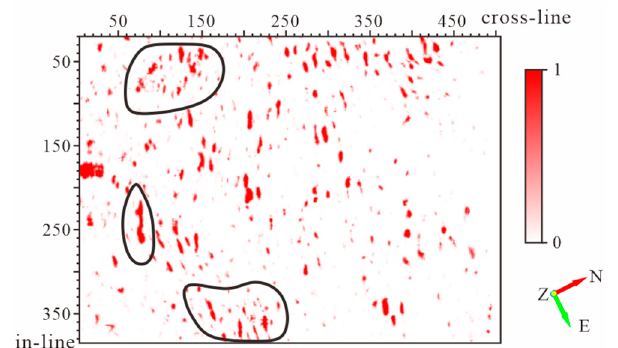
Figure 8. Network prediction results. It is easy to find that the underground faults and fractures of the hot dry rock in the Gonghe basin of Qinghai are mainly in the northwest direction, and some faults are in the east–west direction. The structure is complex, and small-scale faults are very devel- oped.